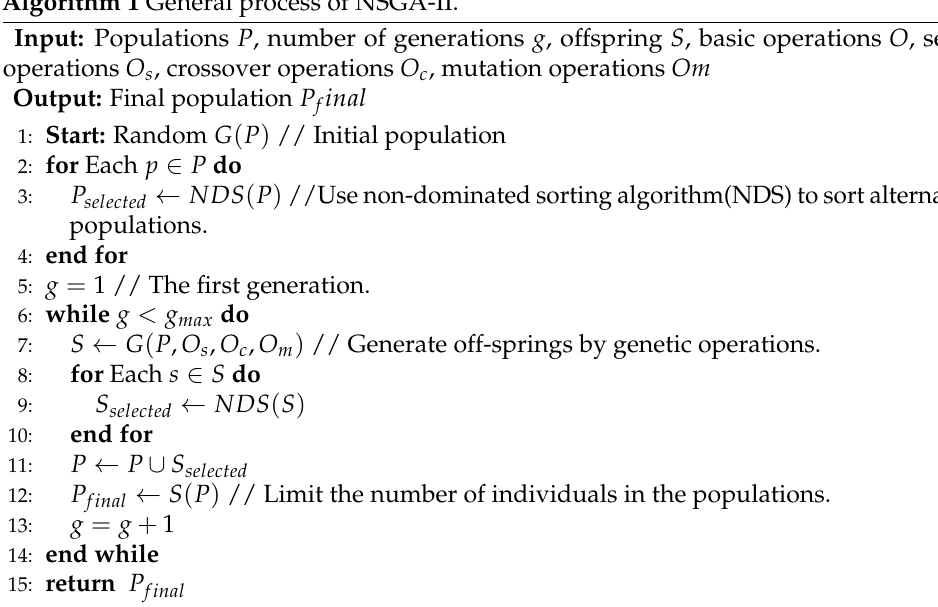
Algorithm 1 General process of